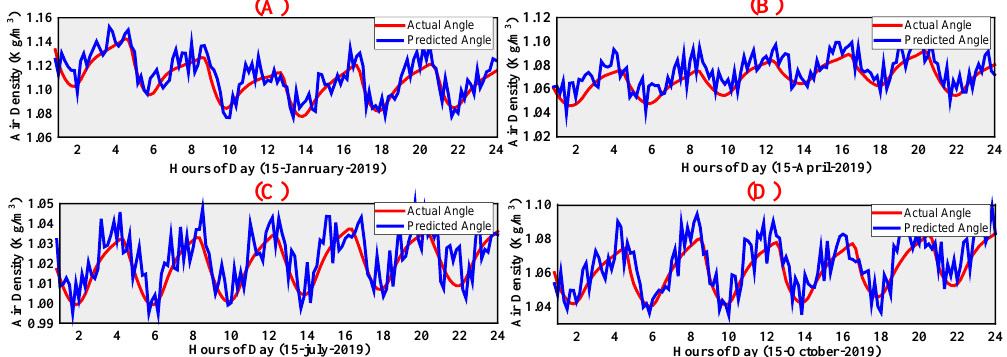
Figure 9. Variation in air density for one day during ( A ) winter, ( B ) summer, ( C ) spring, and ( D ) autumn. Table 2. Error comparison with state-of-the-art methods for the spring season.